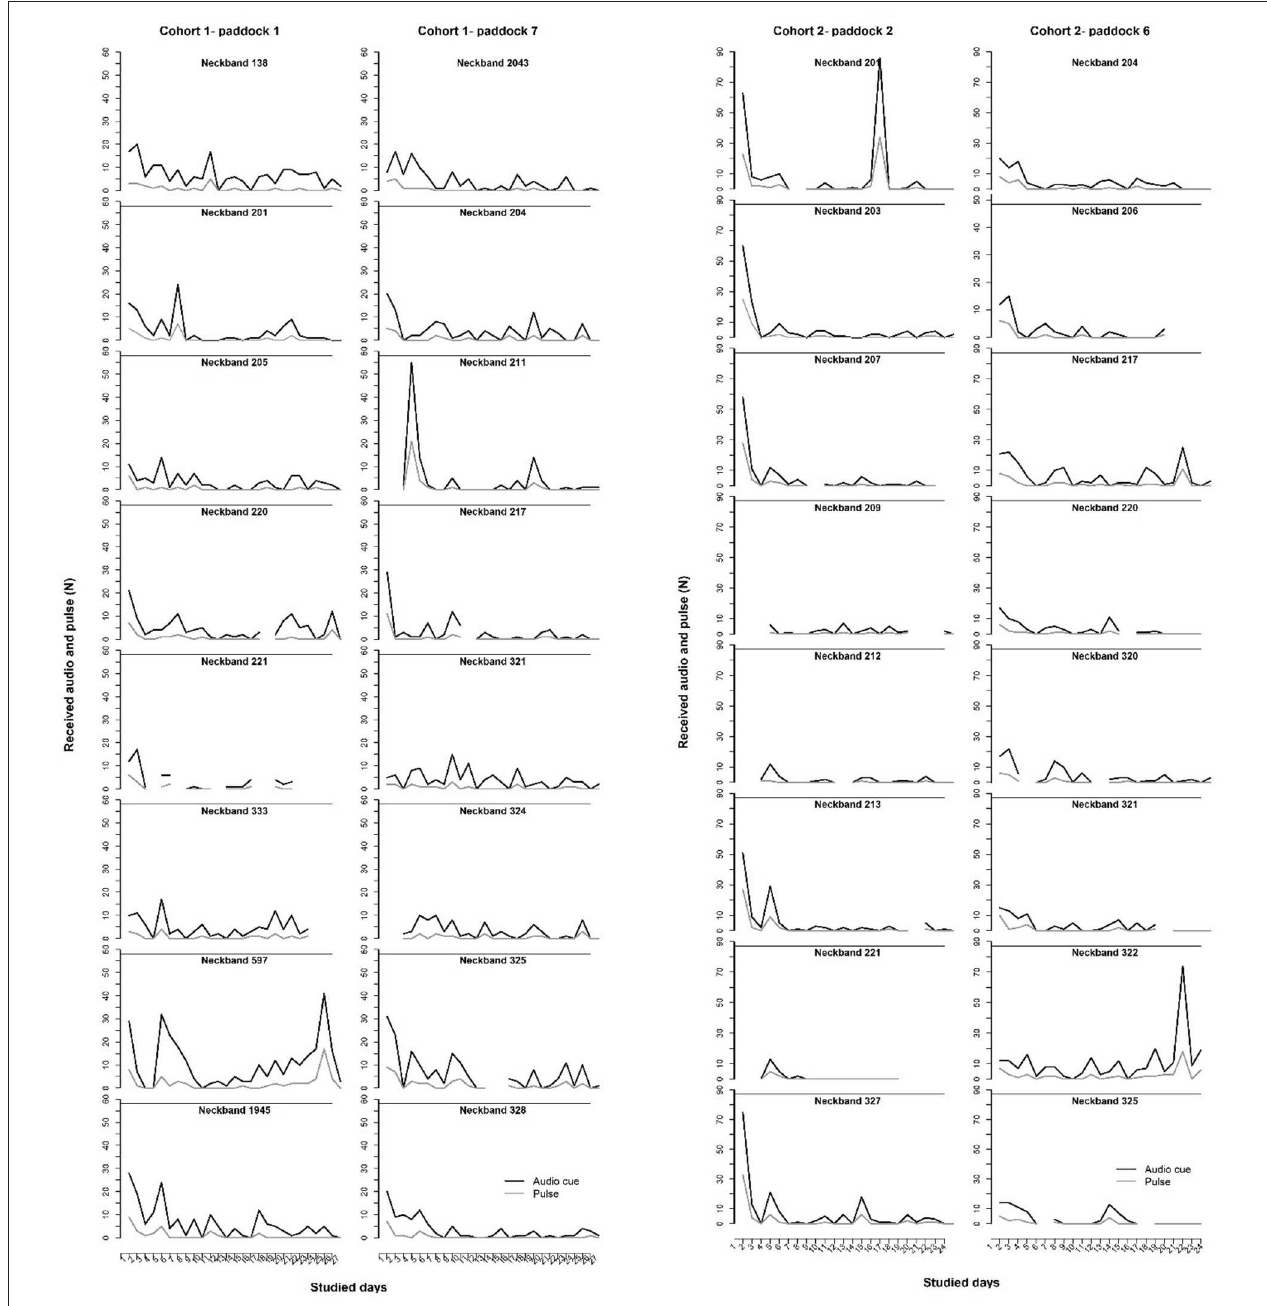
FIGURE 5 | The audio cues and electrical pulses received by each individual animal across the trial duration for each of the four virtual fence groups (indicated by paddock number) across two cohorts. Missing values on specific days are where the neckbands missed recordings, this occurred frequently with neckband 221 in particular. Neckbands were still functional and delivering cues when recordings were missed. NB: different scales on the y-axes across the two cohorts and fewer recorded days for cohort 2.